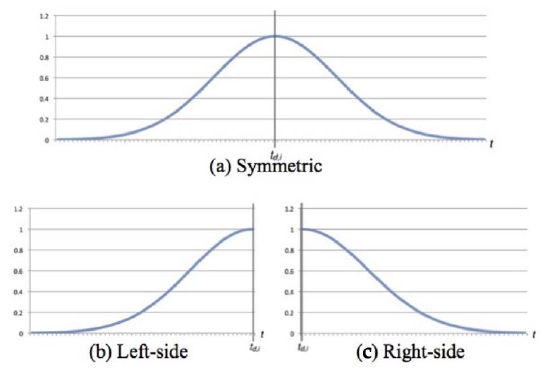
Figure 11. Gaussian membership functions for utterance selection.